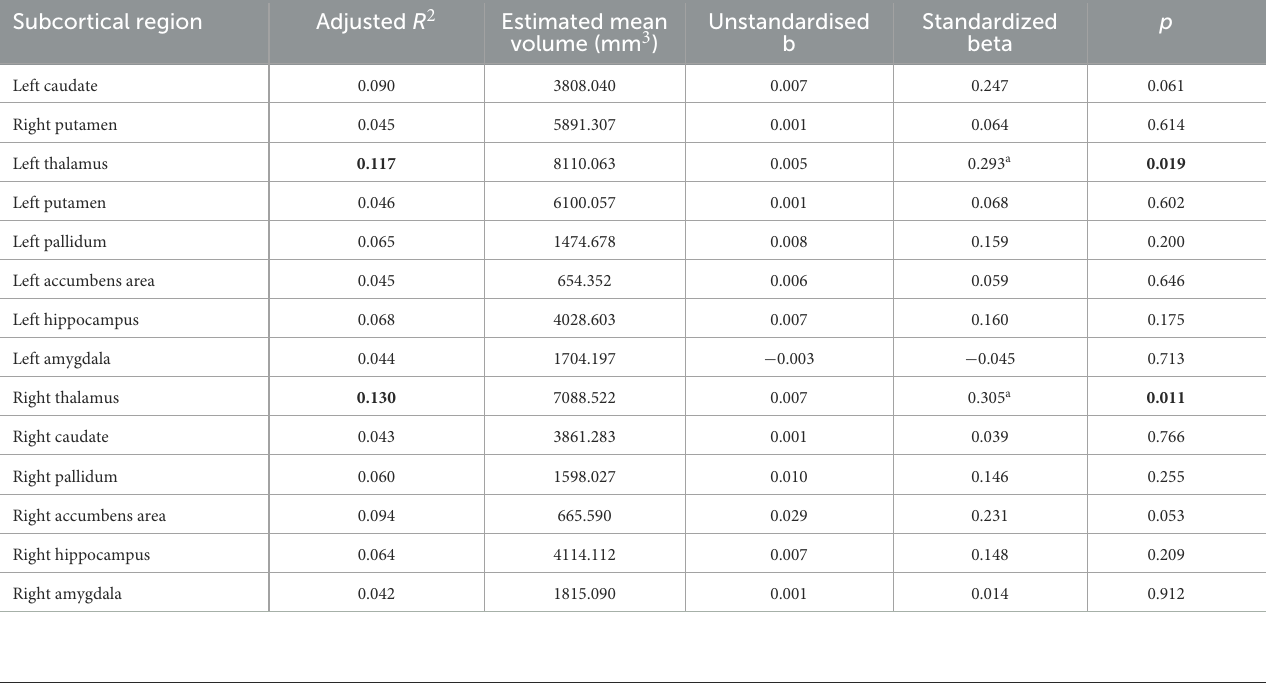
TABLE 8 Regression for working memory index for individual subcortical regions for male patients.